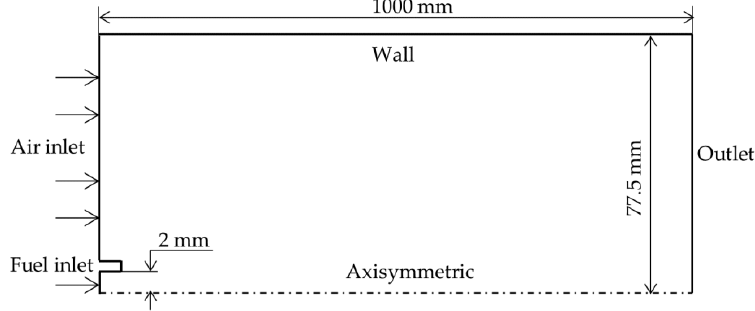
Figure 4. Temperature profiles at the height of ( a ) h = 0.15 m; ( b ) h = 0.30 mm; and ( c ) along the axial direction [7,9]. 2.4. Boundary Conditions Simulations were performed using a transient approach with a steady solution as the initial condition. The boundary conditions for each case are shown in Table 4. Specifically, Case 3 has a forced air stream of 720 kg/hr, and the EA ratio was lower than 1 for the lean 0 . 0 00 . 0 20 . 0 40 . 0 6 400 800 1 2 0 0 1600